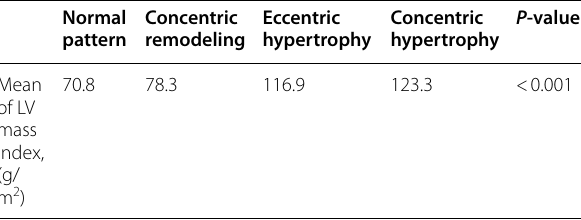
Table 6 Comparison between the four LV geometric pattern regarding the LV mass